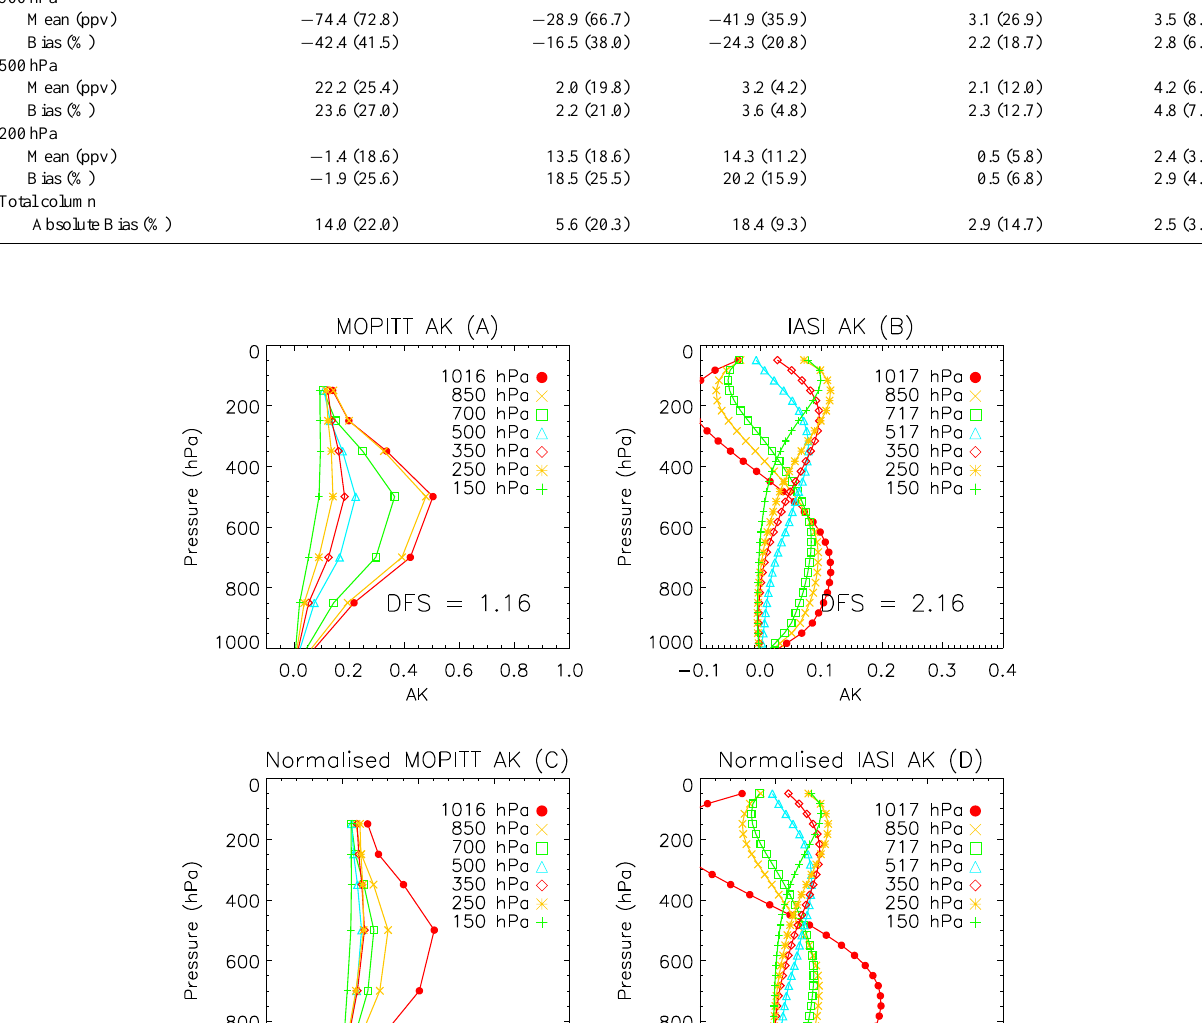
). The units N ). The units of N